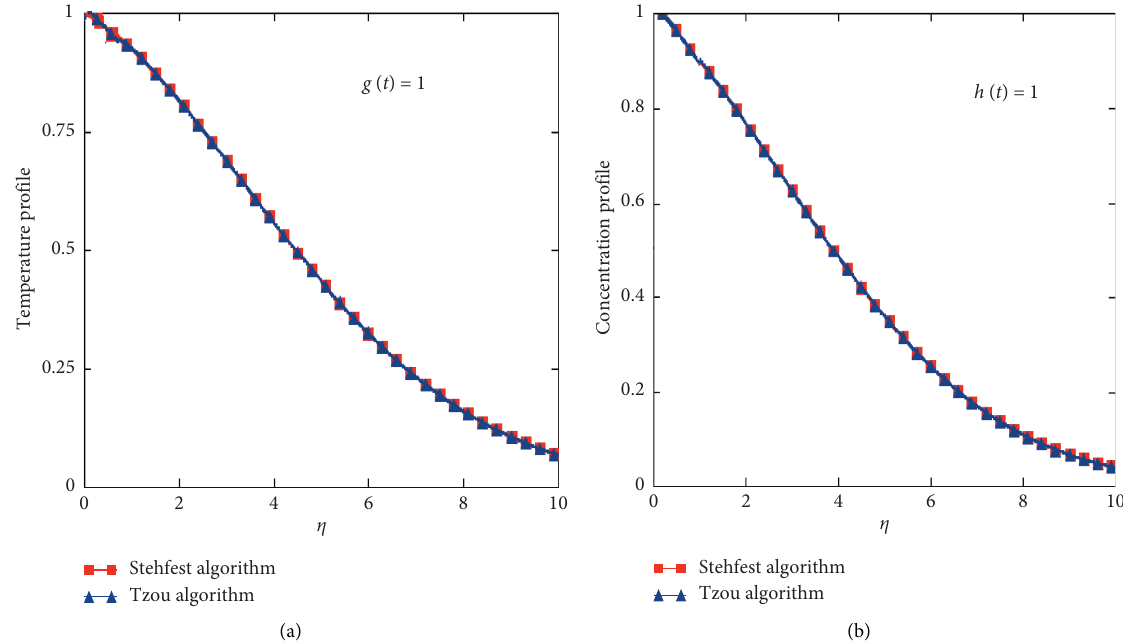
Figure 2: Profiles of inverted temperature and concentration with Stehfest’s and Tzou’s algorithms for (a) g ( t ) � 1 and (b) h ( t ) �